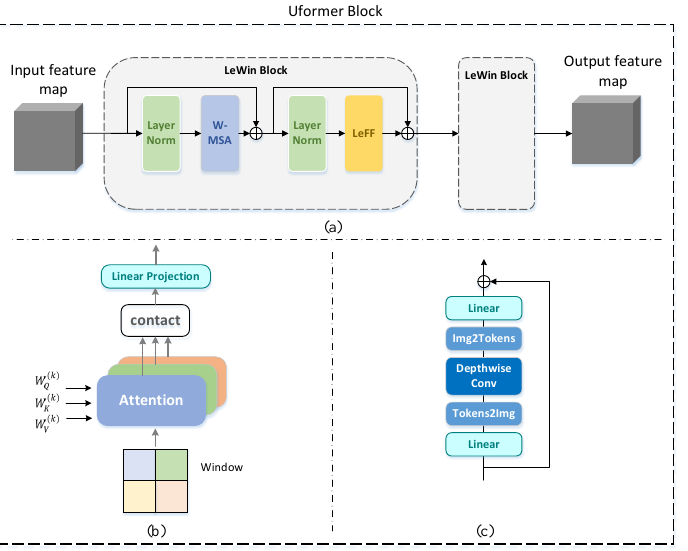
Figure 3. ( a ) An overview of the Uformer block. ( b ) Calculation method of window-based multi-head self-attention (W-MSA). ( c ) The structure of the locally-enhanced feed-forward network (LeFF).